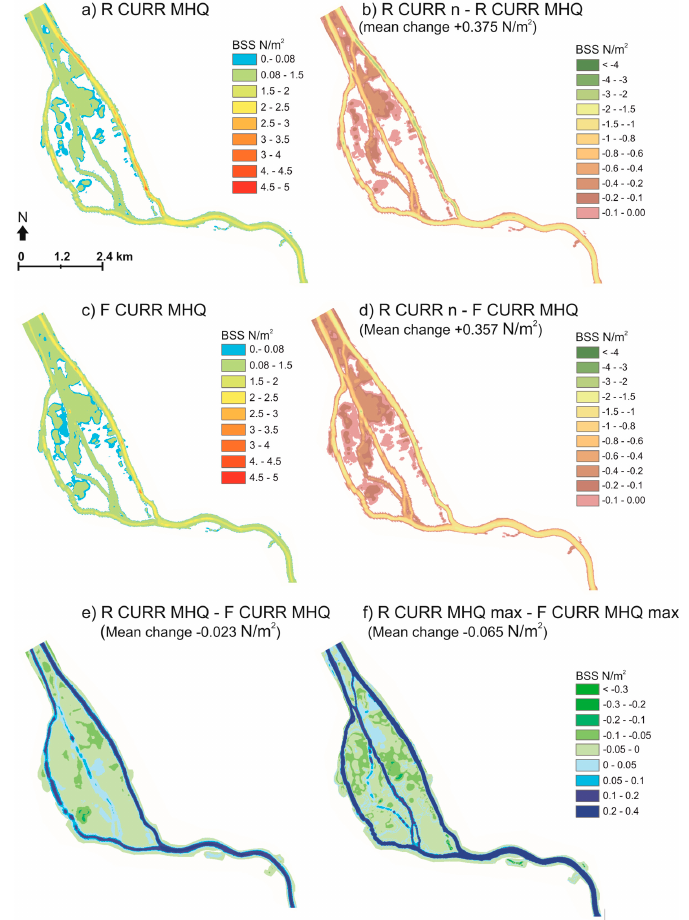
Figure 7. Bed shear stress during flood events: ( a ) the distribution of BSS at the control period (R CURR MHQ); ( b ) the di ff erence in BSS between the normal and flood flow in the control period (R CURR n – R CURR MHQ); ( c ) The distribution of BSS in the climate change period with current regulation rules (F CURR MHQ); ( d ) the di ff erence in BSS between the normal and flood flow in the climate change period (RCURR CURR n – F CURR MHQ); and the di ff erence in BSS between the MHQ floods of the reference and climate change periods: ( e ) with normal water level (R CURR MHQ – F CURR MHQ); and ( f ) with maximum water level (R CURR MHQ max – F CURR MHQ max (BSS). The mean di ff erences are marked in the